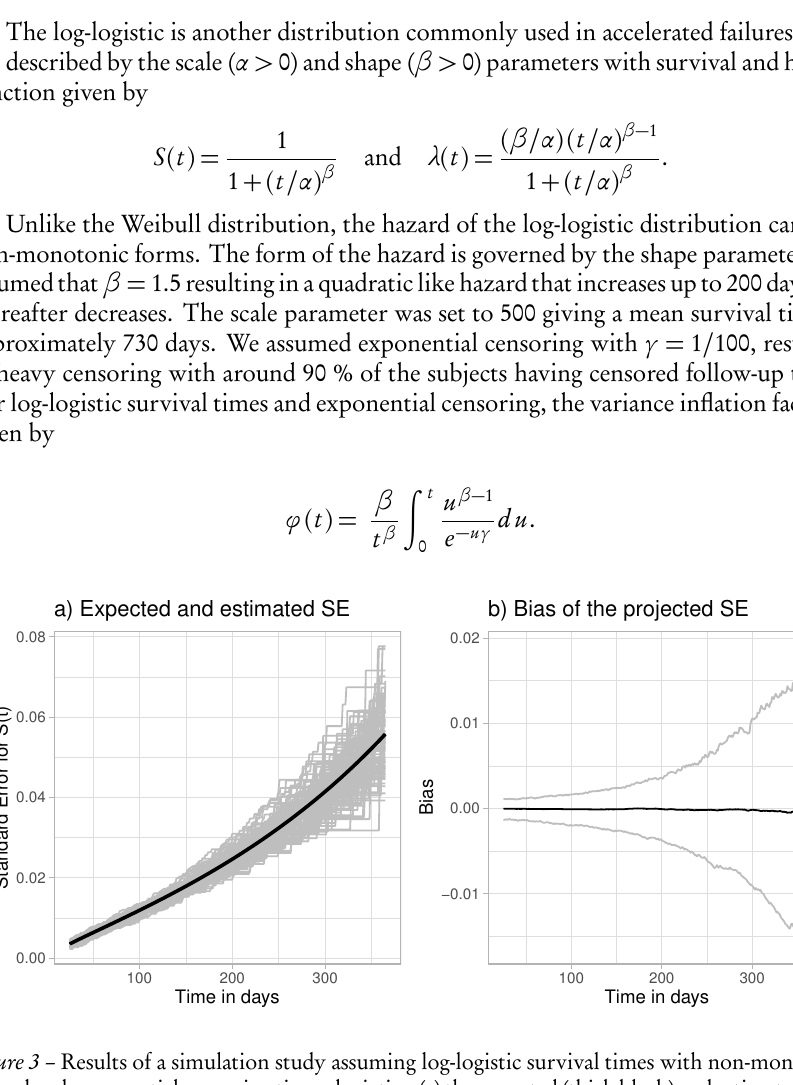
Figure 3 – Results of a simulation study assuming log-logistic survival times with non-monotonic hazard and exponential censoring times depicting (a) the expected (thick black) and estimated (thin grey lines) SE of the survival curve and (b) the bias of the projected SE with 95 % Monte Carlo confidence